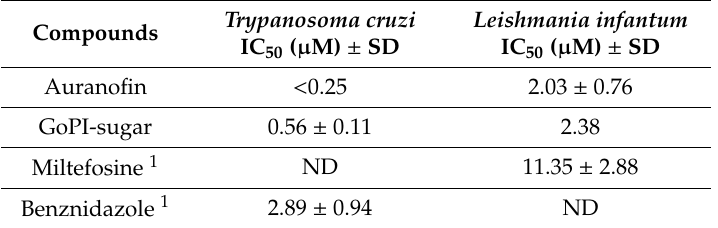
Table 7. In vitro activities of gold(I) complexes in T . cruzi and L . infantum